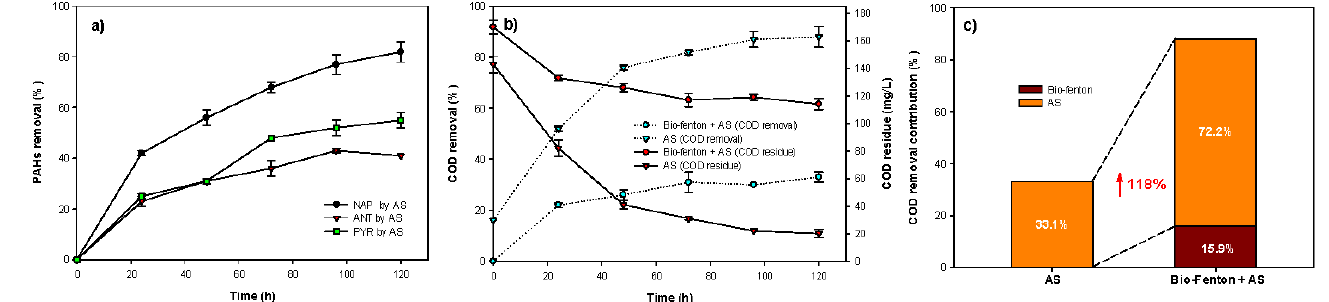
Figure 3. Combined Bio-Fenton with activated sludge for PAH removal: ( a ) PHA removal by activated sludge (AS); ( b ) COD removal by AS with/without Bio-Fenton; ( c ) COD removal contribution.